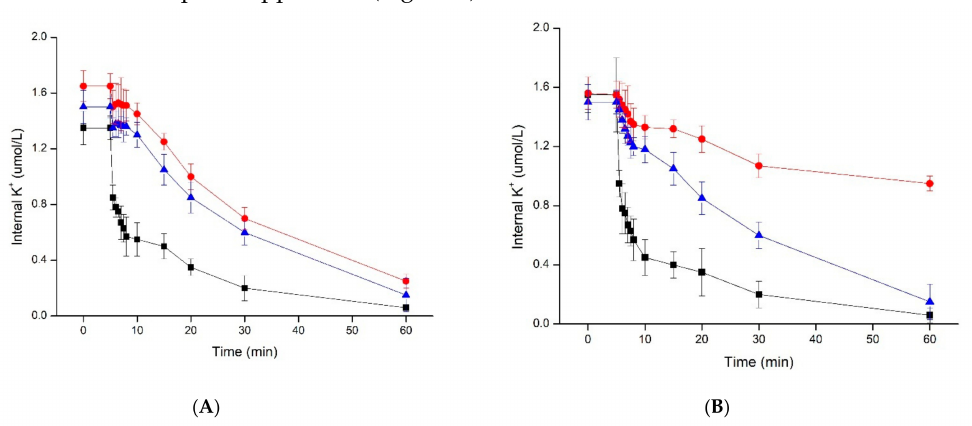
Figure 2. Efflux of K + from cells of S. aureus ATCC 25923 ( A ) and S. aureus CMCC 26570 ( B ) after treatment with plantaricin YKX at pH 8 ( • ), pH 7 ( (cid:78) ), and pH 6 ( (cid:4) ).